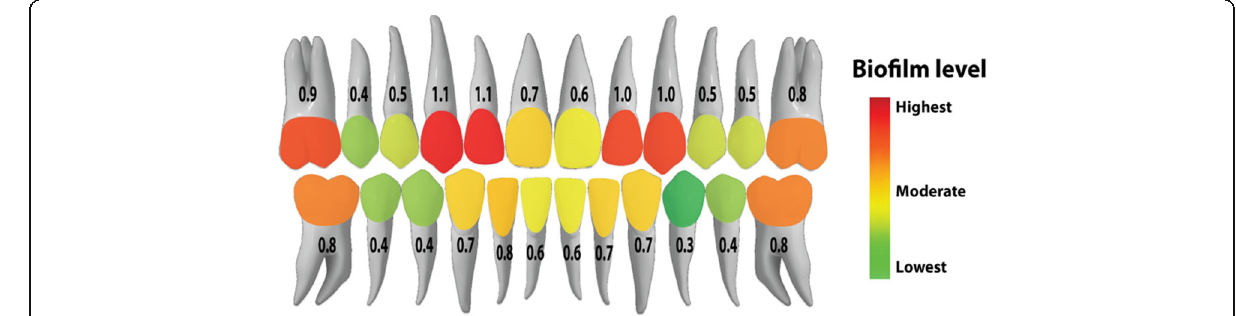
Fig. 2 Mean levels of biofilm formation on each tooth as indicated by the plaque index and a color-coded